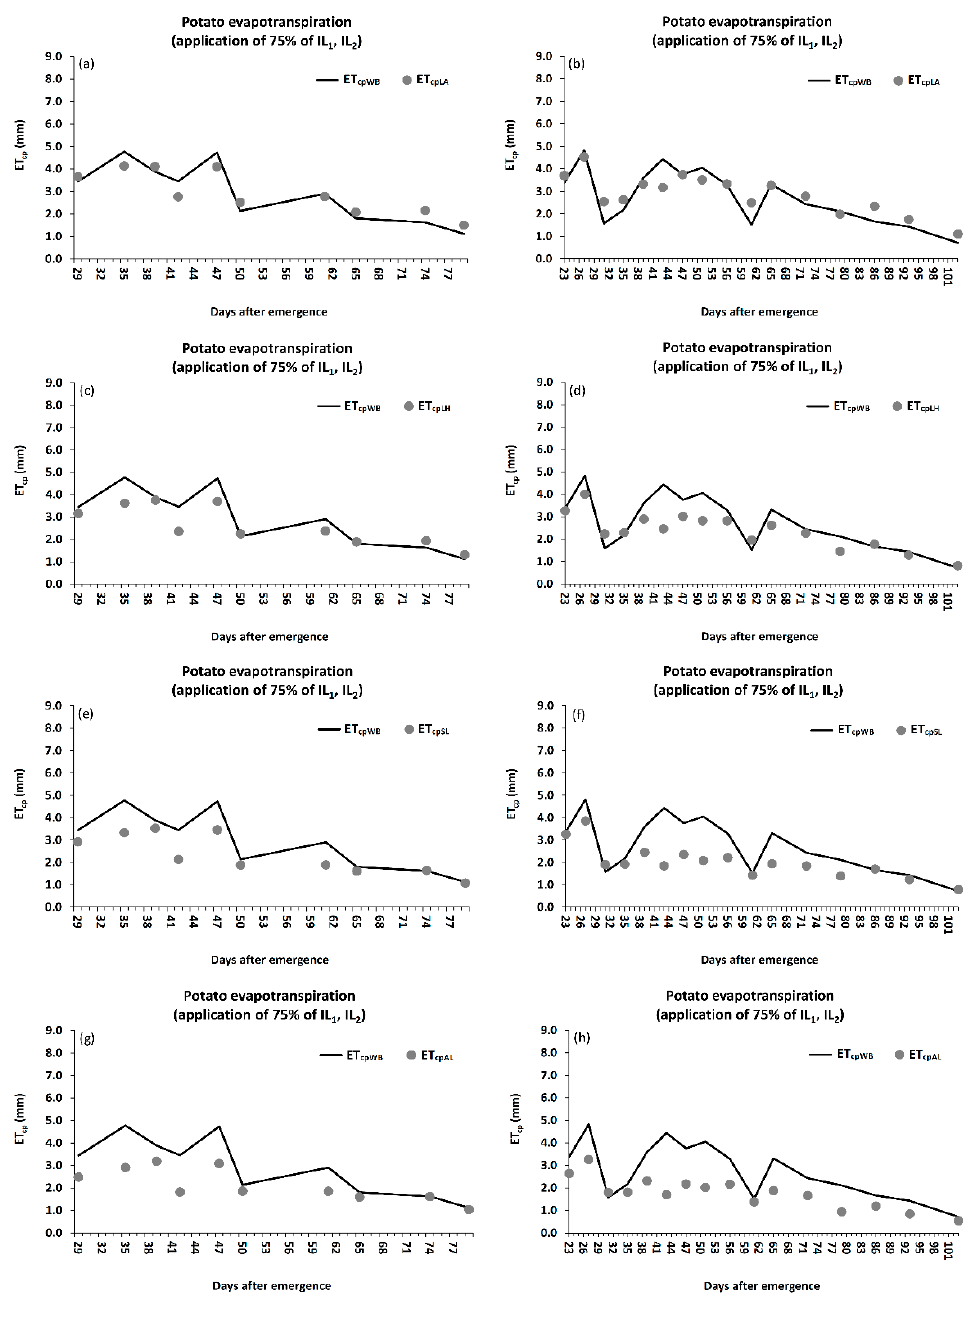
Figure 11. Comparison of daily average ET cp by soil water balance method and PM method with different canopy resistance approaches on an application of 75% of IL 1 (IL 2 ) for 2018/2019 ( a , c , e , g ) and 2019/2020 seasons ( b , d , f , h ).